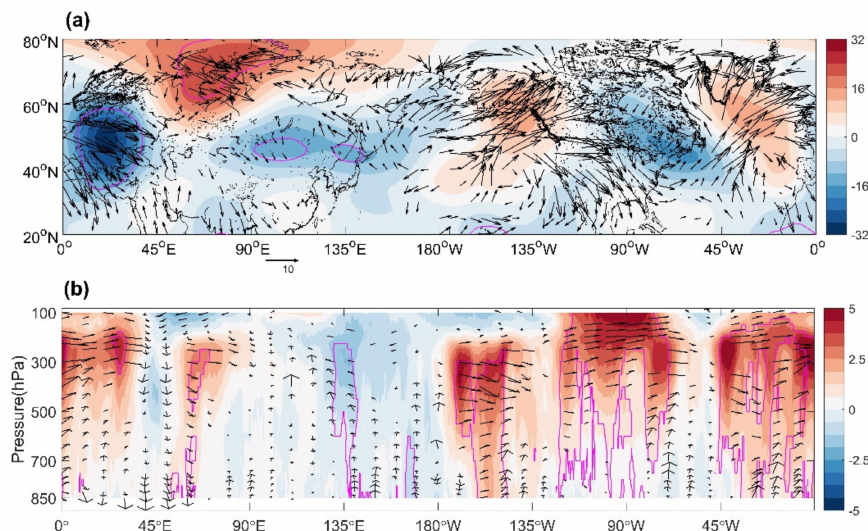
Figure 6. The estimated responses of ( a ) geopotential height (shading, unit: gpm) and horizontal WAF (vectors, unit: m 2 s − 2 ) at the 300-hPa level and ( b ) zonal component of WAF (shading, unit: m 2 s − 2 ) and WAF (vectors, unit: m 2 s − 2 for horizontal component; − 10 − 2 Pa m s − 2 for vertical component) along the 30 ◦ –80 ◦ N meridional average in DJF onto the KEI 2 months earlier. Magenta contours represent where the geopotential height and zonal component of WAF anomalies are significant at the 90% confidence level in ( a , b ) respectively. Only the WAF passing the 90% confidence level is plotted.